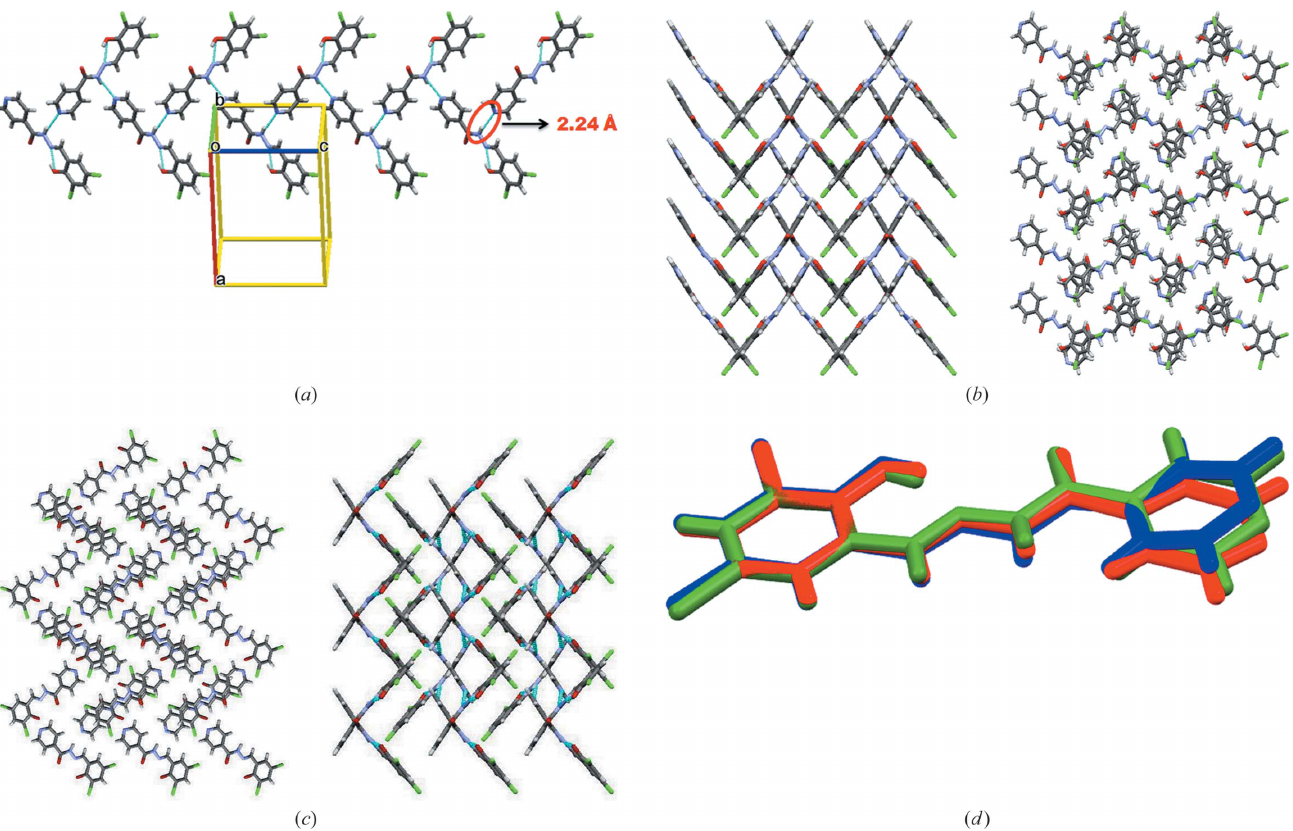
Figure 3 ( a ) The one-dimensional chain of Form II of Compound-A propagating through the N—H (cid:2)(cid:2)(cid:2) N (pyridine) synthon. ( b ) Packing of molecules along the a and b axes (Form II). ( c ) Packing of molecules along the a and c axes (Form III). ( d ) Overlay of the Form I (green), Form II (blue) and Form III (red, high-temperature polymorph) crystal structures (Compound-A).